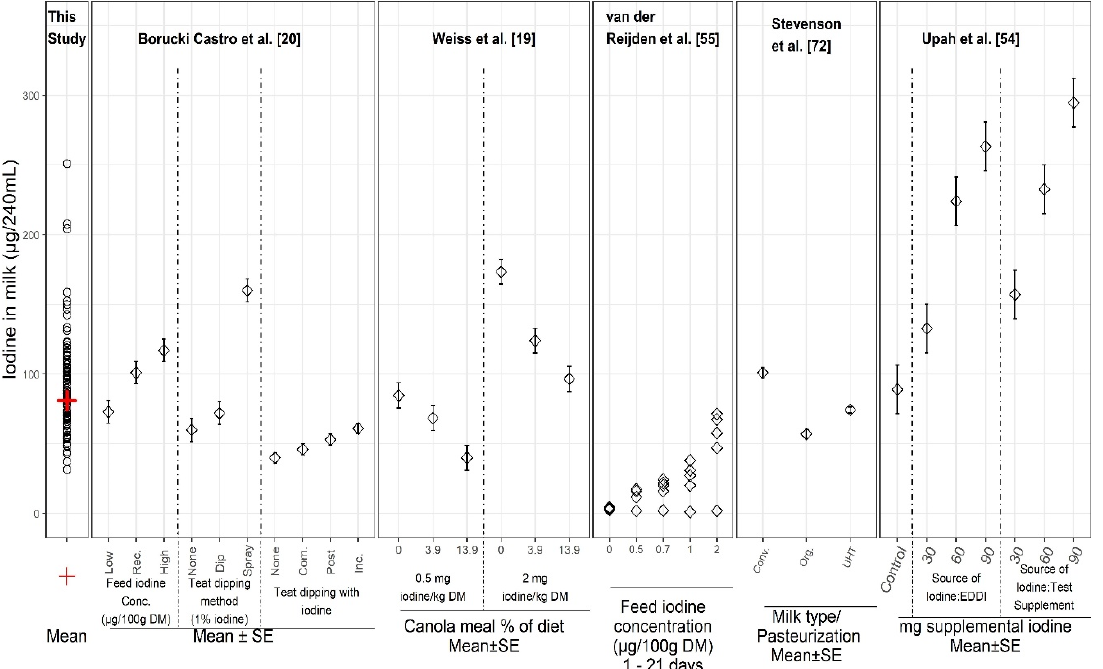
Figure 4. Iodine concentrations in individual milk samples from this study (left column) and from several reports on controlled experimental studies of variables affecting the iodine content of milk.